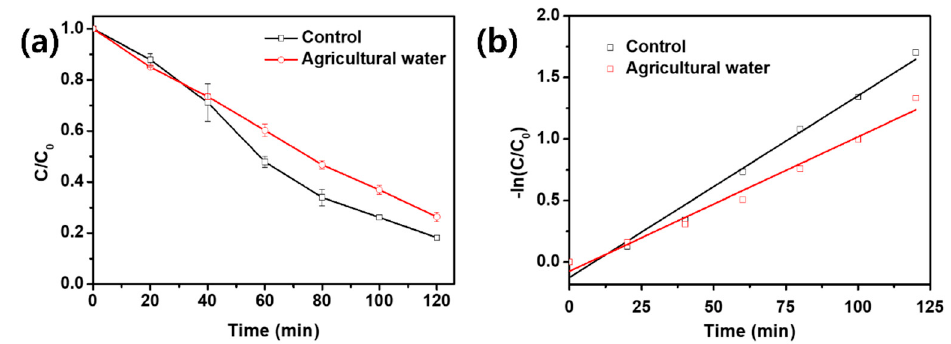
Figure 4. ( a ) Effect of actual agricultural water on OTC degradation and pseudo-first-order kinetic plots for ( b ) OTC under actual agricultural water conditions. Table 1. Observed rate constants ( k ) and half-lives ( t 1/2 ) determined in the photodegradation of agricultural antibiotics under various reaction